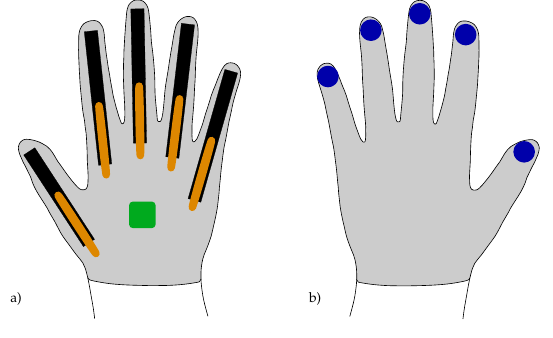
Figure4. FinalsensorconceptofSenGlove. Variantshown: small-sizedhandswithatextilesupport structureforthehand(grey). a)dorsalviewwithinertialmeasurementunit(green),bendingsensors Figure 4. Final sensor concept of SenGlove. Variant shown: small-sized hands with a textile support fortheflexionofanentirefinger(black),bendingsensorsfortheflexionoftheMCPjoint(orange),b) structure for the hand (grey). ( a ) dorsal view with inertial measurement unit (green), bending sensors palmarviewwithpressuresensors(blue). for the flexion of an entire finger (black), bending sensors for the flexion of the MCP joint (orange), The variant for small-sized hands allows the Bend Labs ® sensors to span the MCP, PIP and DIP joints of the fingers II to V and the MCP and IP joints of finger I (see ( b ) palmar view with pressure sensors FigureA2a). Theymeasurethecombinedflexionandextensionanglesofthreeandtwo joints,respectively. Thisvariantisevensuitableforwomenofthefirstpercentile. Inthevariantformedium-sizedhands,theBendLabs ® sensorsspantheMCPand PIPjointsofFingerIItoV(seeFigureA2b). Thisvariantfitsmenuptothe99thpercentile. From the 5th percentile for men and the 95th percentile for women, a stretching of the sensorsisnecessarytocompensatefortheincreaseinlength.